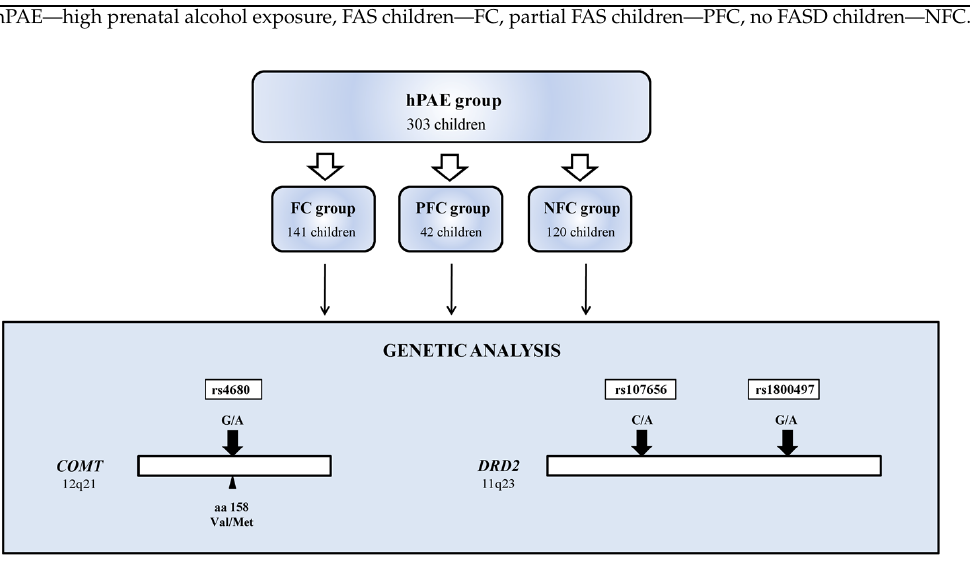
Figure 1. The flowchart of the study design (hPAE—high prenatal alcohol exposure, FC—FAS children, PFC—partial FAS children, NFC—no FASD children).